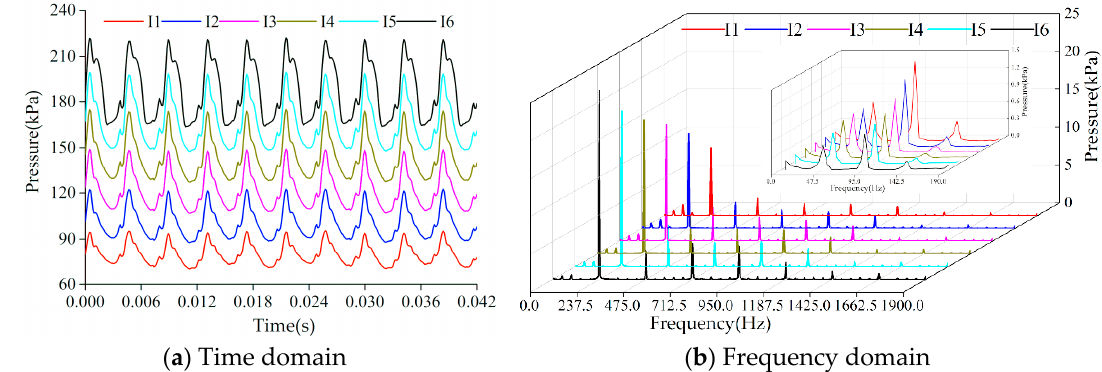
Figure 17. The time and frequency domain diagrams of pressure fluctuation at monitoring points on the middle streamline of a single impeller channel when the monitoring points are stationary relative to the rotational coordinate system.